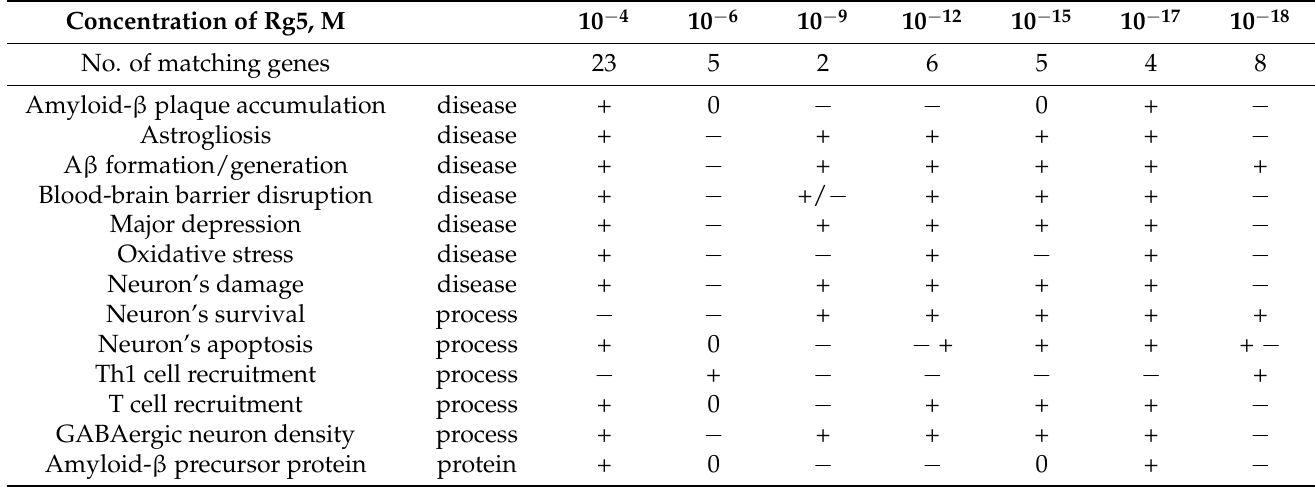
Table 2. The number of genes matching neuroinflammation signaling pathway and predicted effects of Rg5 in various diseases and cellular processes associated with neuroinflammation 1